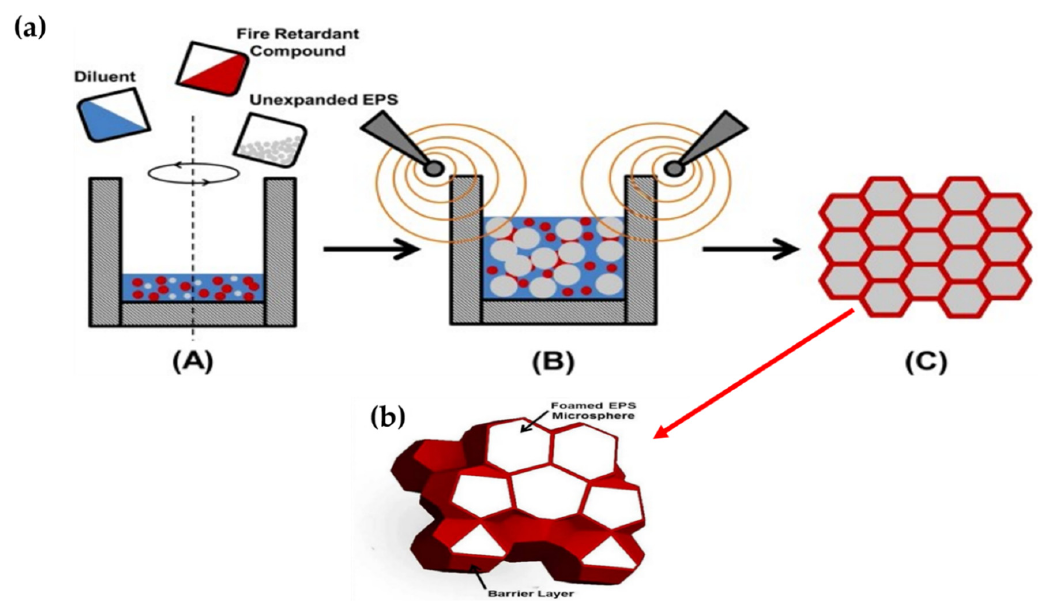
Figure 4. ( a ) Process setup and procedure to produce composite EPS foam from an expandable suspension; ( b ) composite EPS foam, a 3D pictorial model with cross-section. Reprinted with permission from the authors of [44]. Copyright © (2015) Society of Plastic Engineers.